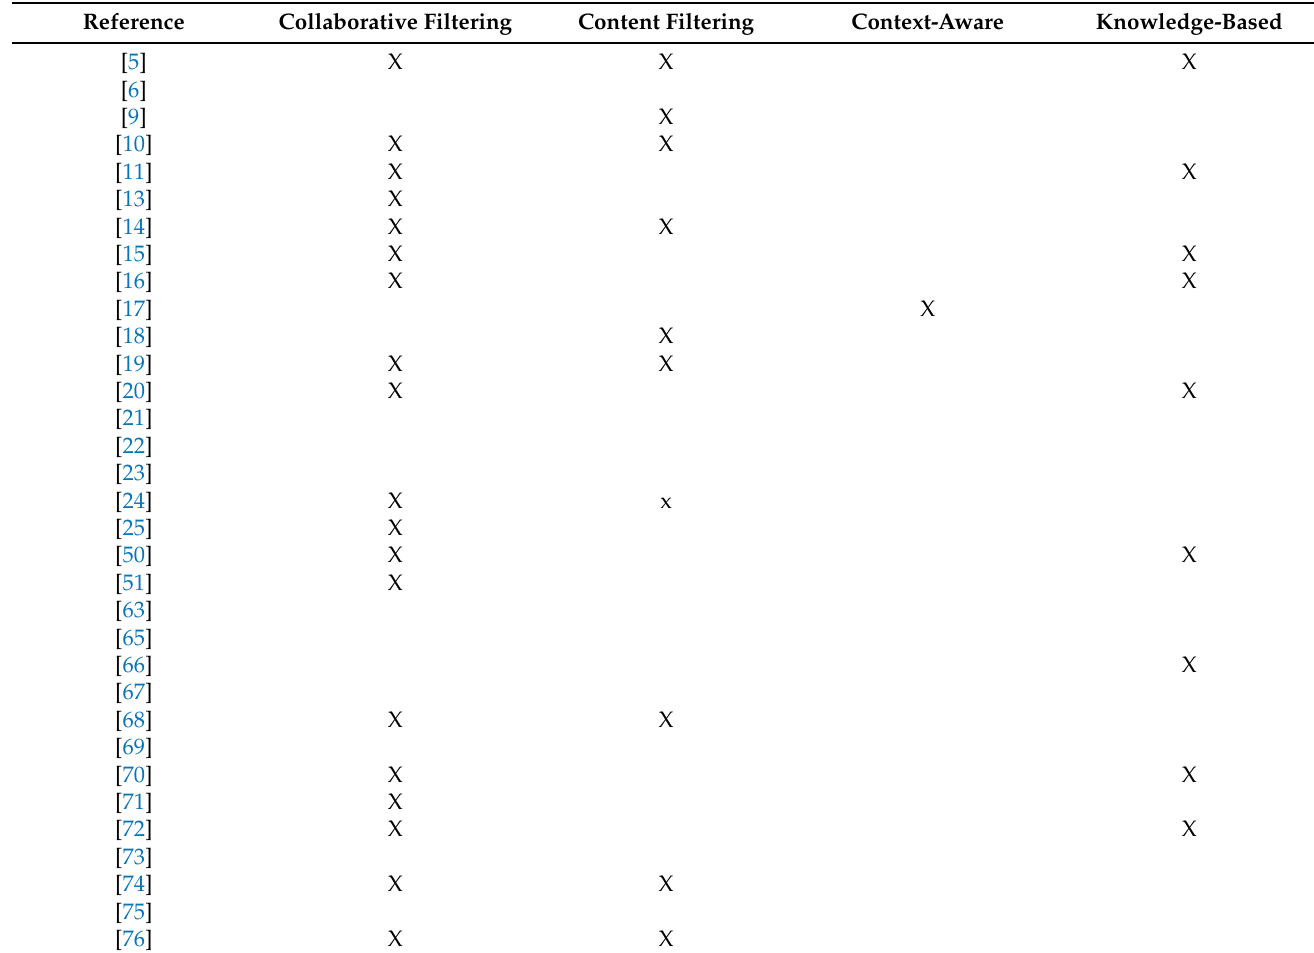
Table 2. Recommendation approaches used in the analyzed